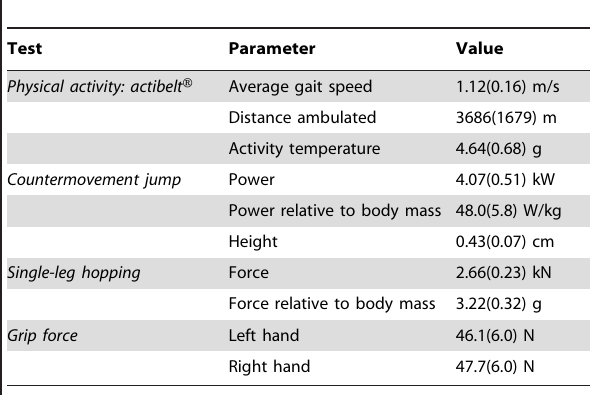
Table 1. Physical activity and neuromuscular variables at first